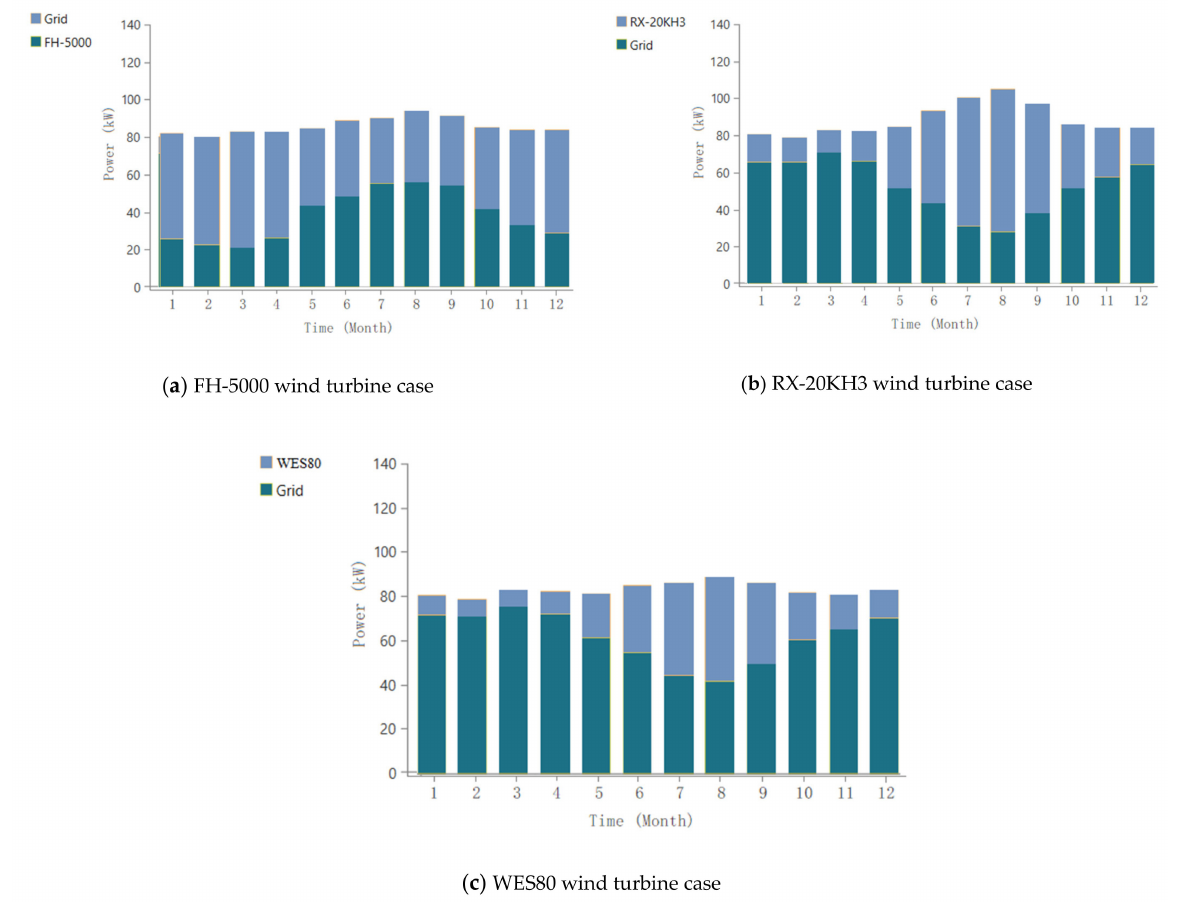
Figure 17. Monthly average of electric power generation in Kudat. The penetration of wind energy to the electric power demand for 1 year in Putrajaya is presented in Figure 18. The FH-5000 model penetrates the same amount as that in Kudat, i.e., 44.3%, and the RX-20KH3 model covered 40% of the load requirements. In contrast, the WES80 model exhibits the lowest renewable penetration by covering 26.3% of the demand requirements. Similar to the Kudat case, all the scenarios exhibit high intensity during the monsoon season.